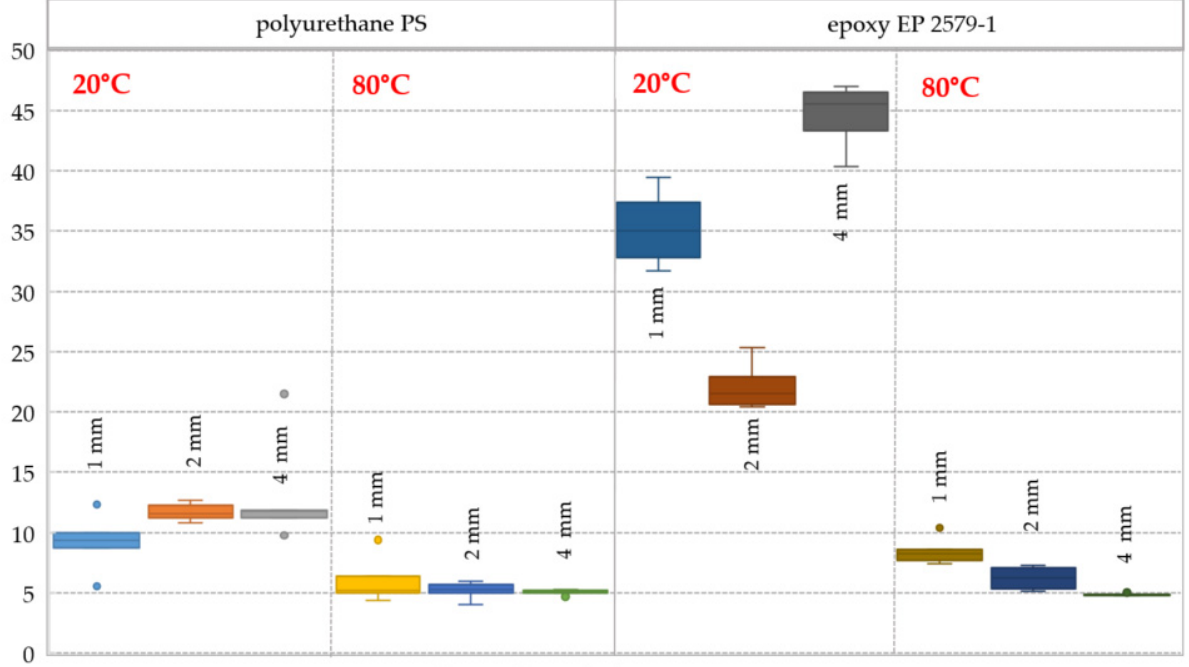
Figure 12. Box and whisker plots for the maximum destructive force at 20 °C and 80 °C.